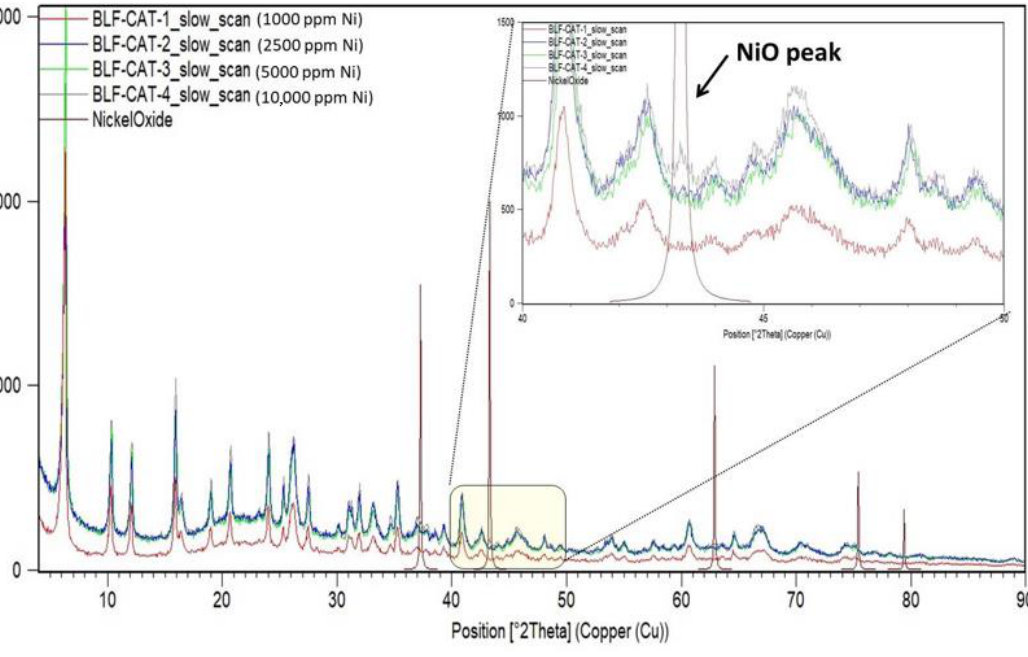
Figure 7. PXRD patterns of BLF-CAT-x samples which are industrial FCC catalysts loaded with increasing amounts of Ni and deactivated in the lab following typical cyclic propylene steaming (CPS) deactivation protocols. The pattern of NiO is also included for comparison, while the inset figure focuses on the 2 θ region of 40 to 50°, which includes the most prominent reflection of NiO, i.e., (2 0 0) at ~43.3°.